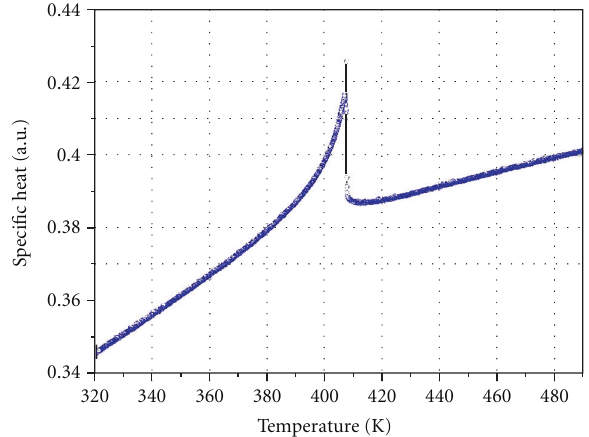
Figure 4: Temperature dependence of specific heat of BaTiO 3 single crystal around the paraelectric-ferroelectric phase transition point T c